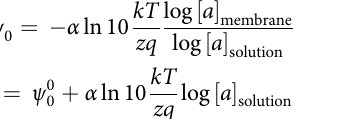
stages of the fabrication process.